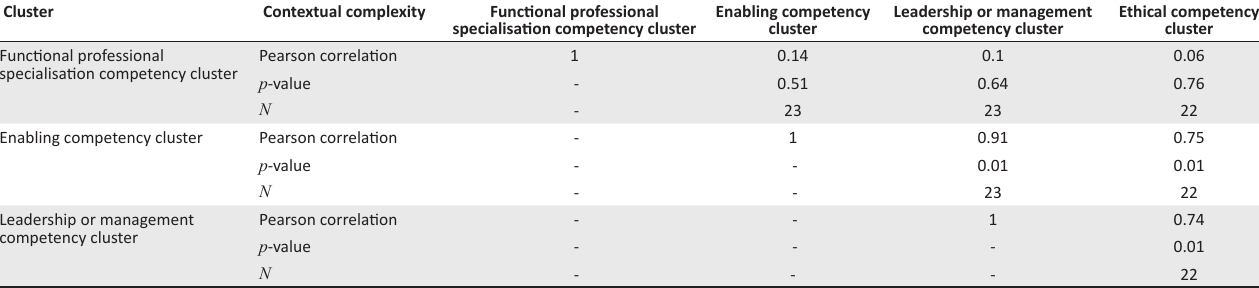
TABLE 3: Inter-correlations of the four competency clusters. Cluster